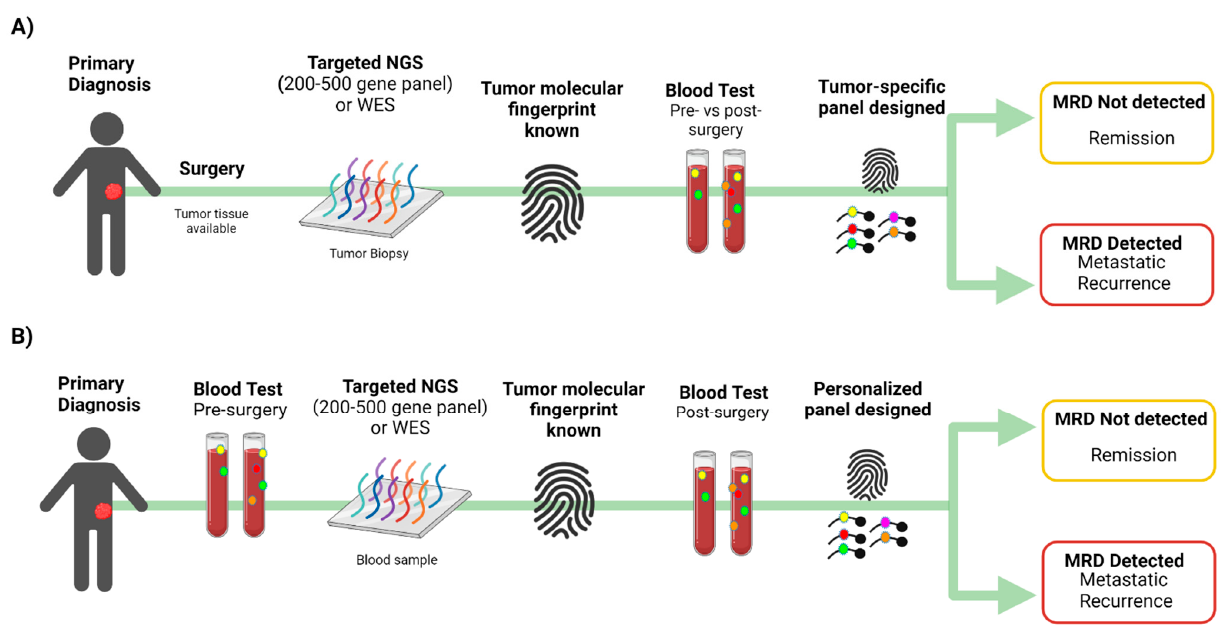
Figure 3. The number of tracked mutations impacts the ctDNA detection rate. Overview of MRD testing, including why tracking many mutations is important, particularly when there is a low fraction of cancerous cfDNA in the bloodstream. ( A ) Tumor tissue is available; ( B ) Tumor tissue is not available. WES, whole-exome sequencing. Created with